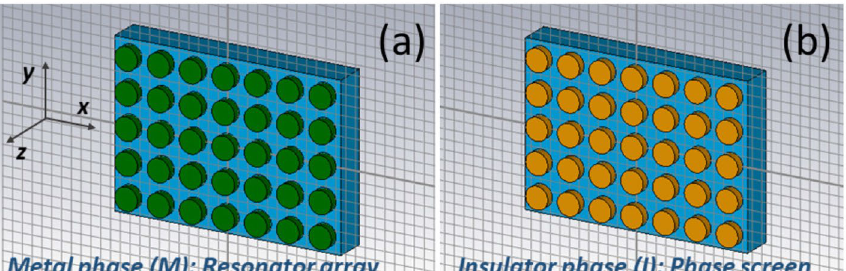
Figure 1. Schematic of a generic single-array metasurface with thin VO 2 meta-atoms of arbitrary geometry placed on dielectric substrate (shown in light blue color) when VO 2 is in ( a ) the M phase (dark green color) and ( b ) the I phase (orange color). The Cartesian coordinate system is also